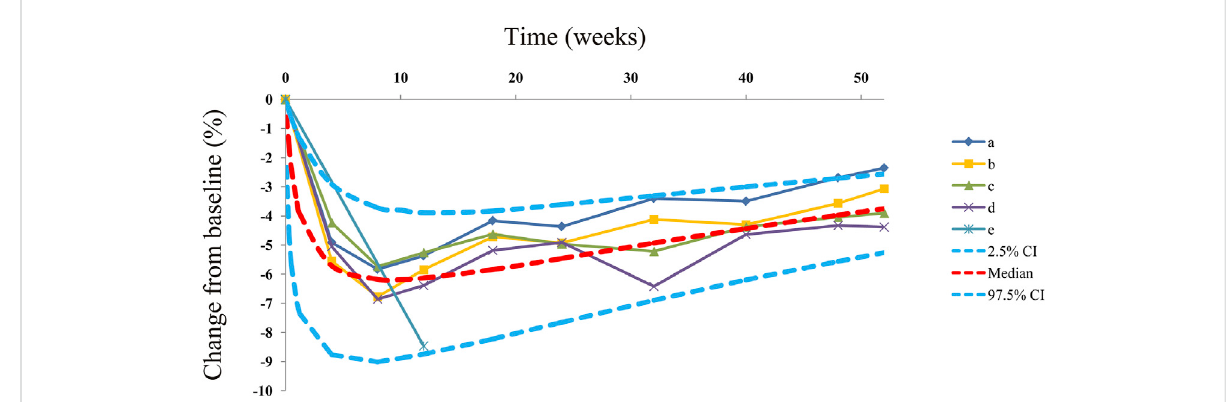
FIGURE 4 Prediction-correctedvisualpredictivecheckplots.Median,2.5%CI,and97.5%CIweresimulatedusingtheMonteCarlomethod( n